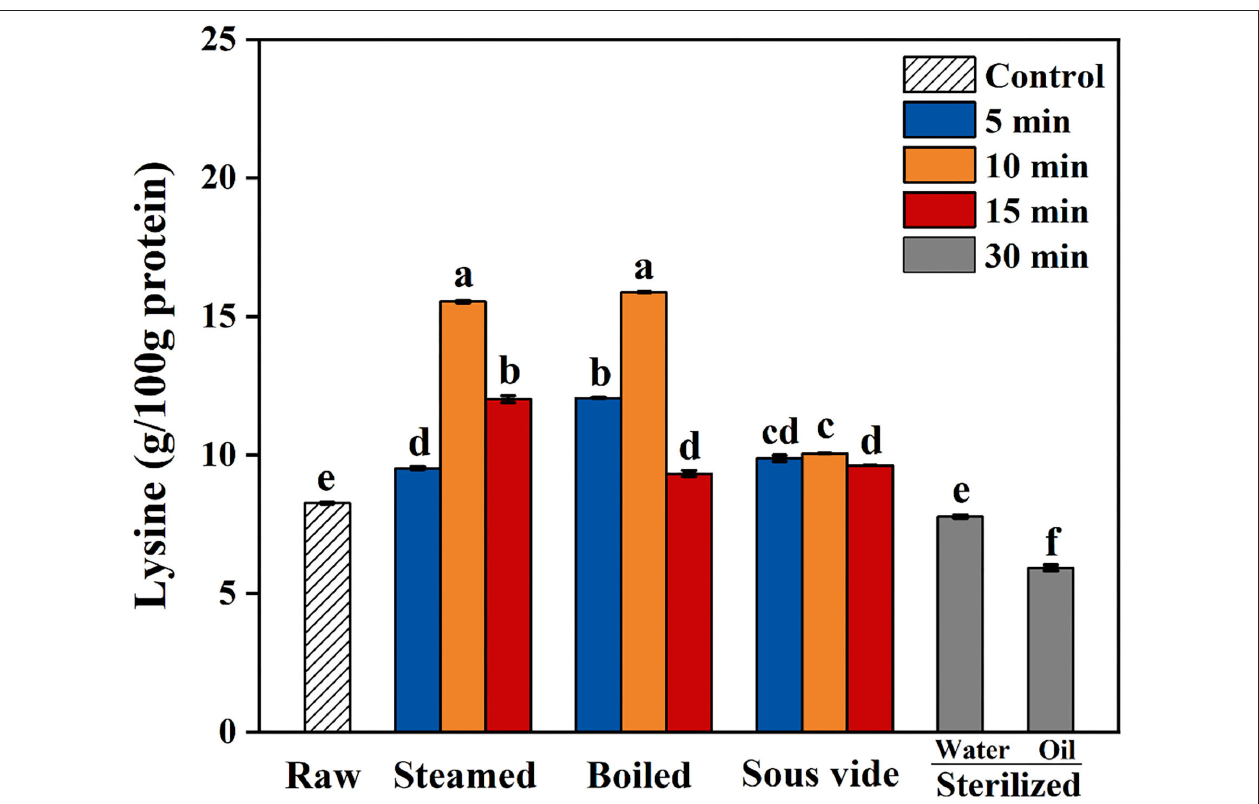
FIGURE 3 | Content of lysine in raw and processed oysters under different thermal processing conditions. Error bars indicate standard deviation ( n = 3). Samples designated with different lowercase letters were significantly different ( p < 0.05).